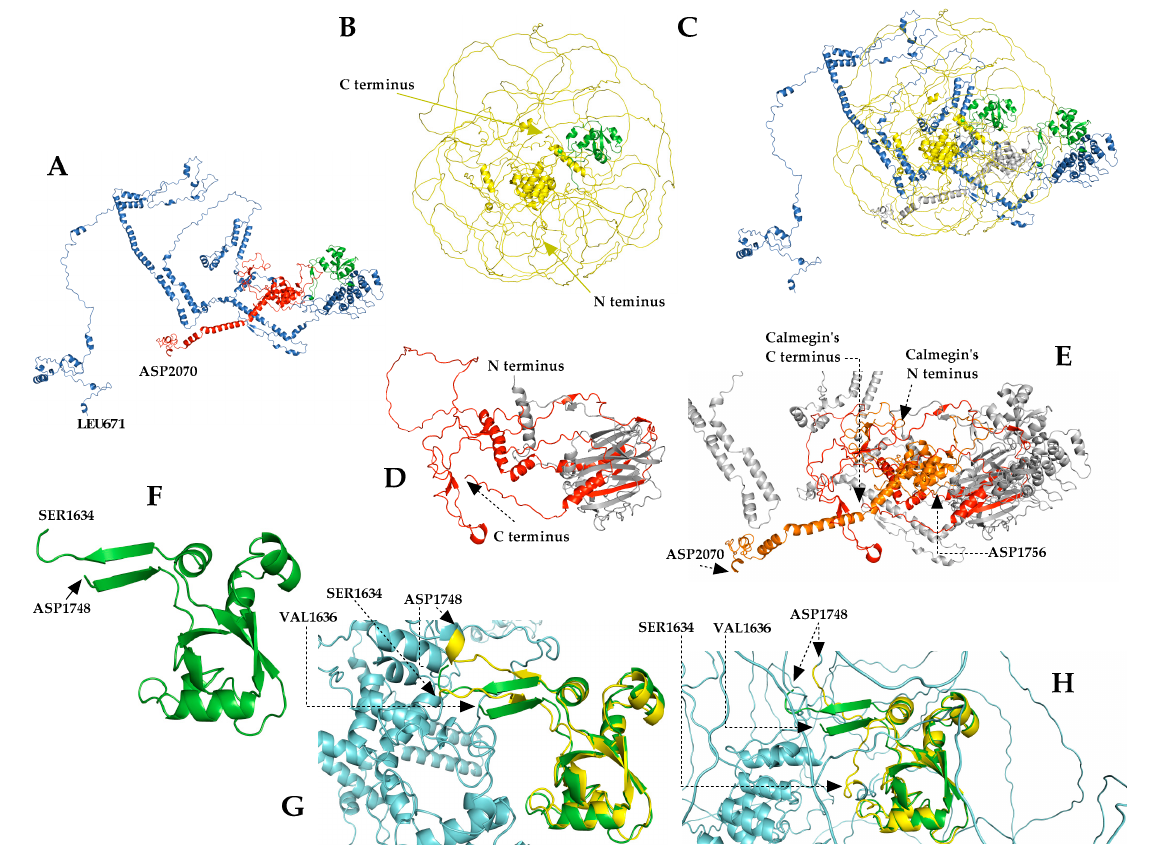
Figure 5. Structural comparison of the AlphaFold (AF) wild-type BCOR and calmegin protein with Robetta chimera protein, and a comparison of the wild-type experiment-determined PUFD domain with the AF- and Robetta-generated PUFD domains. ( A ): The Robetta-generated chimera protein (confidence: 0.28, range 671–2070, according to chimera numbering). The blue color indicates the amino acid sequence that corresponds to BCOR (between 671 and 1755 residues; the BCOR and chimera numbering is the same in this region) and the red color indicates the sequence corresponding to the calmegin protein (range 1756–2070, according to chimera numbering); the green color indicates the PUFD domain of BCOR (range 1634–1748, the BCOR and chimera numbering is the same in this region). ( B ): Proposed structure of the full-length BCOR protein downloaded from the AF database. The yellow color indicates the 1–1755 region of the chimera protein (being equivalent to the full-length BCOR protein), and the PUFD domain of BCOR is highlighted in green. ( C ): Aligned structures of the chimera and BCOR-aligned structure. ( D ): Structure of calmegin (total length 1–610), downloaded from AF database. The amino acid sequence corresponds to the chimera protein (from 1756 to 2070 residues). ( E ): Aligned structure of the chimera and calmegin proteins. Orange indicates the sequence of the chimera protein corresponding to calmegin. ( F ): Crystal structure of the PUFD domain of BCOR (from 1636 to 1748 residues; PDB ID: 4HPL). ( G ): Predicted structure of the PUFD domain in the chimera protein (Robetta, shown in yellow), aligned to the experimentally determined PUFD domain (PDB ID: 4HPL) (green). ( H ): Alignment of the BCOR’s PUFD domain structures, predicted by AF (yellow) and determined experimentally (PDB ID: 4HPL) (green). The light blue color indicates the non-PUFD domain residues of the chimeric protein ( G ) and AF-predicted BCOR protein ( H ).